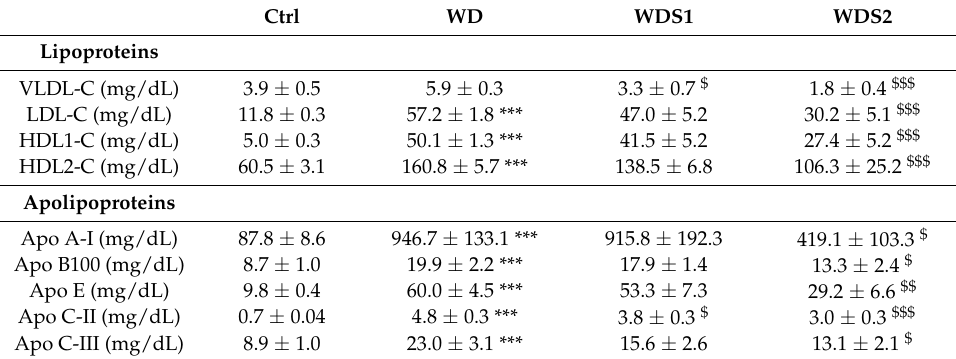
Figure 5. Spirulina administration prevents western diet induced hypercholesterolemia. ( A ) Quantification of plasma non-esterified fatty acids (NEFA) and ( B ) triglycerides. ( C ) Plasma total cholesterol level and ( D ) cholesterol repartition among very low density lipoprotein (VLDL), low density lipoprotein (LDL) and high density lipoprotein (HDL). * p < 0.05, *** p < 0.001 ( n = 9– 10/group), ANOVA. Concentration of circulating lipoprotein cholesterol and apolipoprotein profiles. Cholesterol content in very low density lipoprotein (VLDL), low density lipoprotein (LDL) and high density lipoprotein (HDL). Plasma level of apolipoprotein (Apo) A–I, B100, E, C–II and C–III. *** p < 0.001 vs. Ctrl and $ p < 0.05, $$ p < 0.01, $$$ p < 0.001 vs. WD ( n =